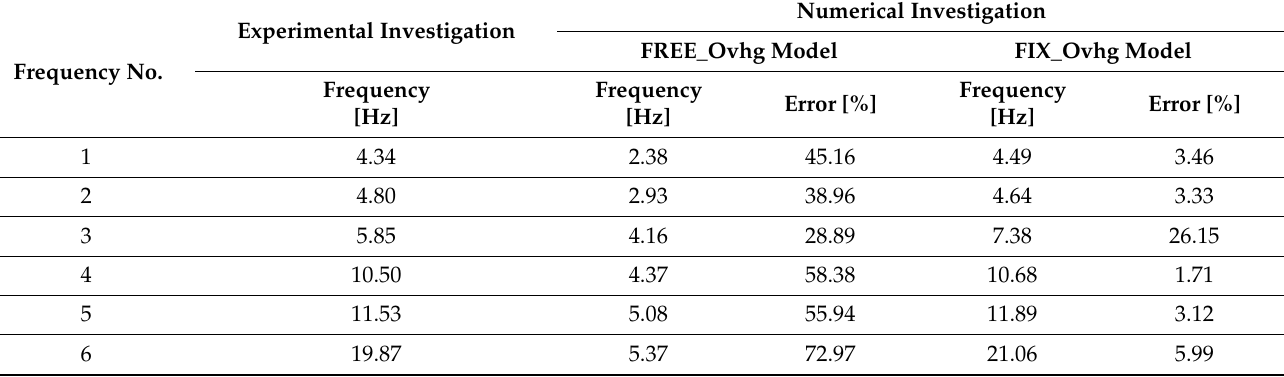
Table 4. Comparison of the experimental and the numerical values of natural frequencies.